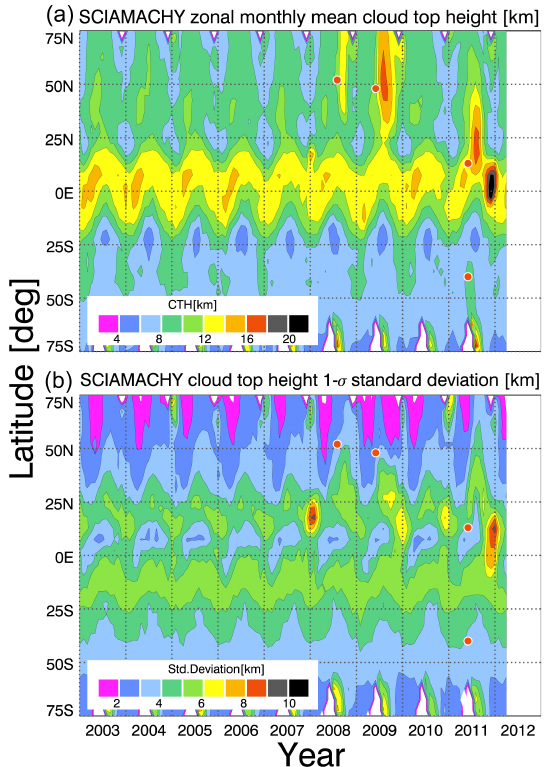
Figure 11. Time series of SCIAMACHY monthly zonal means CTHs (a) and (b) 1 σ standard deviations (in kilometres) for the period from January 2003 to April 2012 between 75 ◦ S and 75 ◦ N. The red dots depict the start dates and latitudes of 4 major volcanic eruptions: Kasatochi in August 2008, Sarychev Peak in June 2009, and both Nabro and Puyehue–Cordón Caulle in June